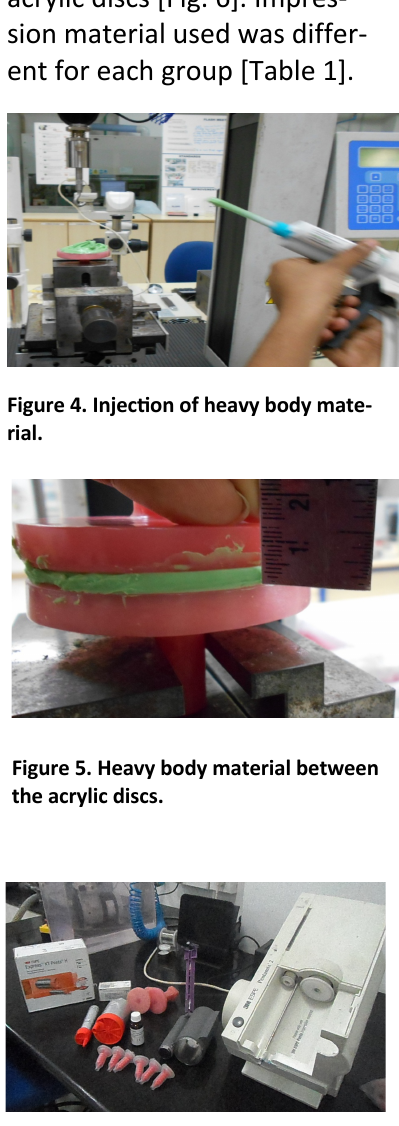
Figure 6. Penta mix dispenser.